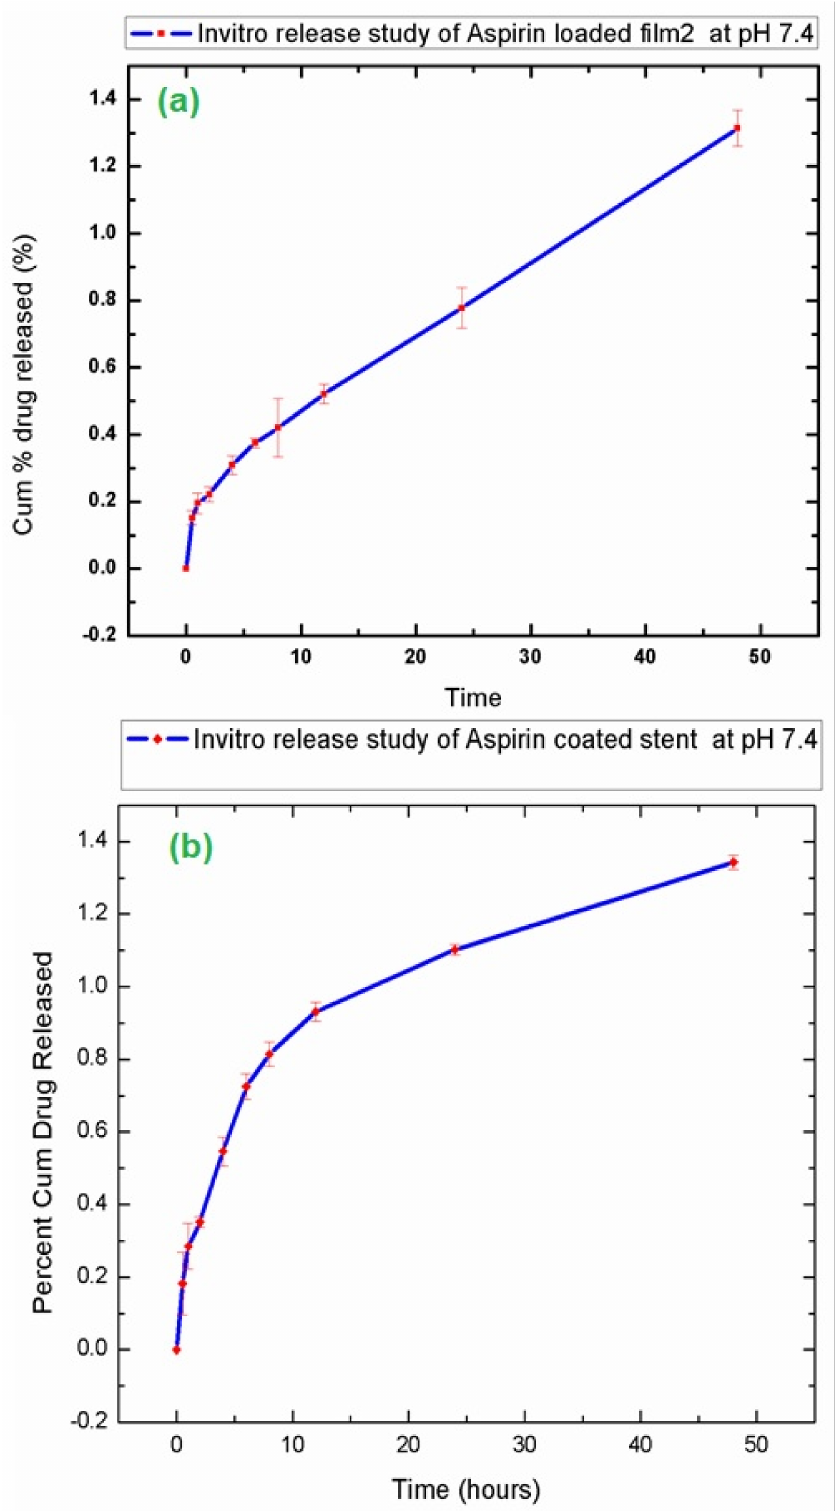
Figure 6. In vitro drug release study of ( a ) Aspirin loaded F-2 (80% PLA and 20%EVA) and ( b ) Aspirin coated